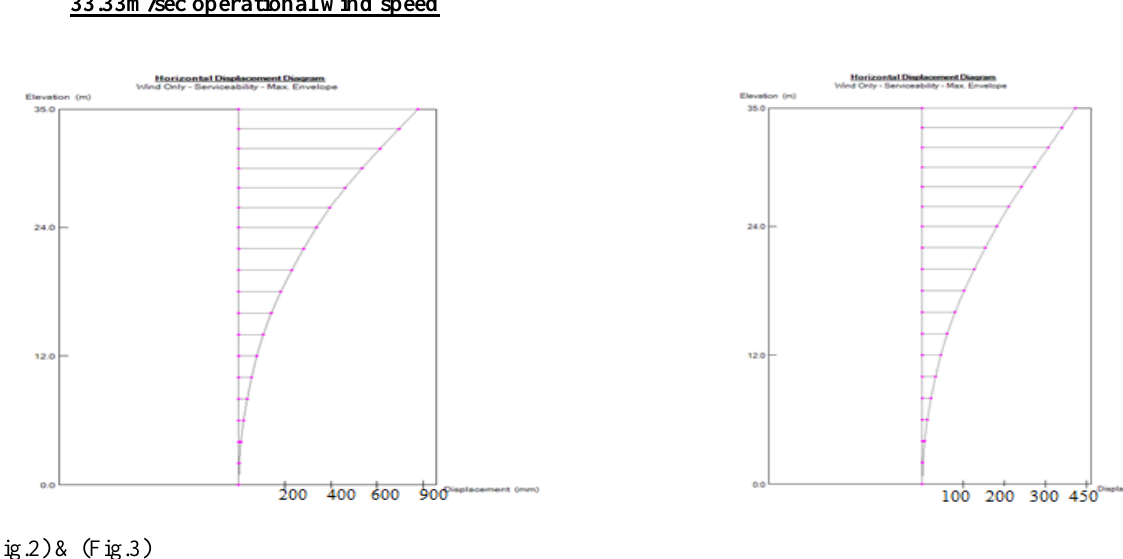
Figure 2 and Figure 3 Lateral Displacement Vs Height for Monopole without camouflaged tower and with camouflaged (Height = 35m and operational wind speed = 33.33m/sec)